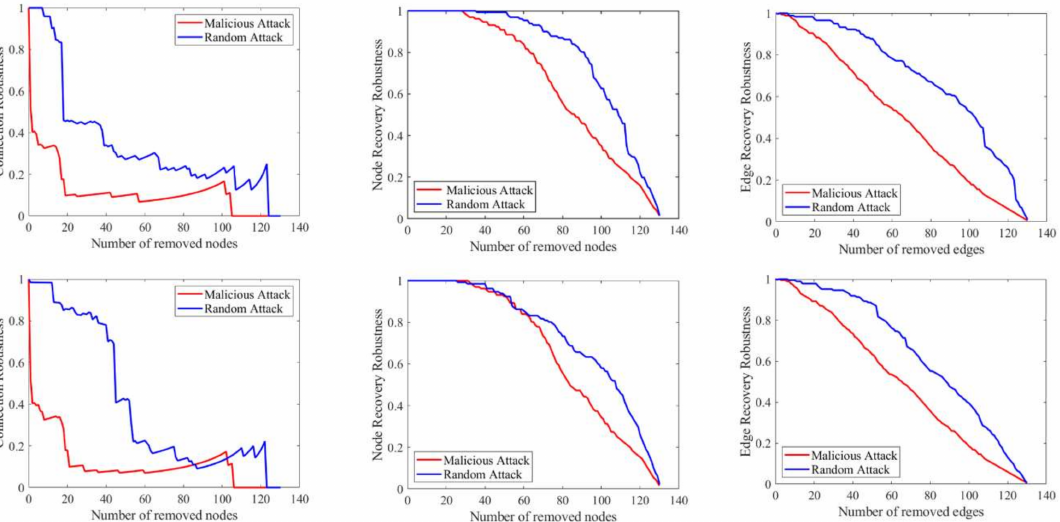
Figure 10. Robustness check of network before and after optimization: network connectivity robust- ness before optimization ( upper left ) and after optimization ( lower left ); node recovery robustness before optimization ( upper middle ) and after optimization ( lower middle ); edge-recovery robustness before optimization ( upper right ) and after optimization ( lower right